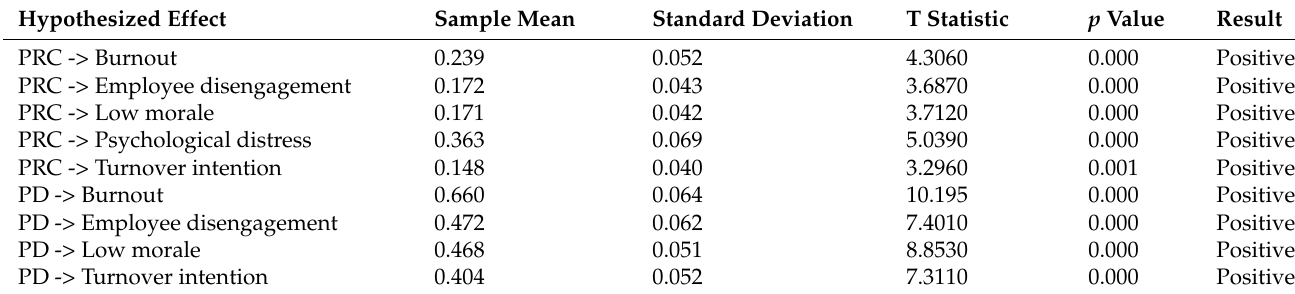
Table 4. Direct effects.